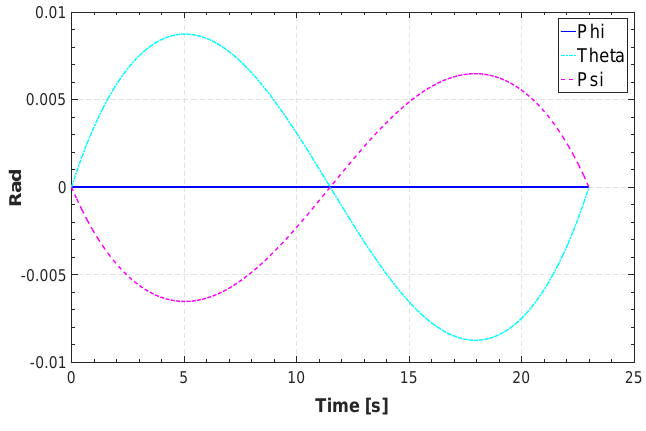
Figure 13. Roll, pitch and yaw angle for TML.